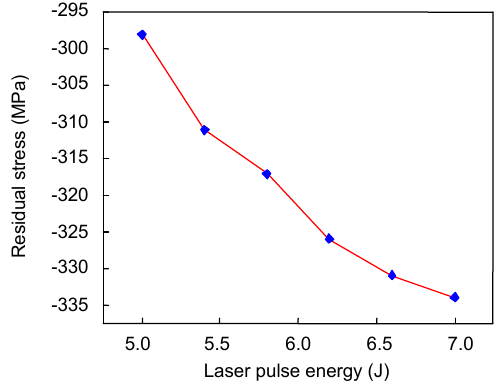
Fig. 3 | Effect of laser pulse energy on surface residual stress.